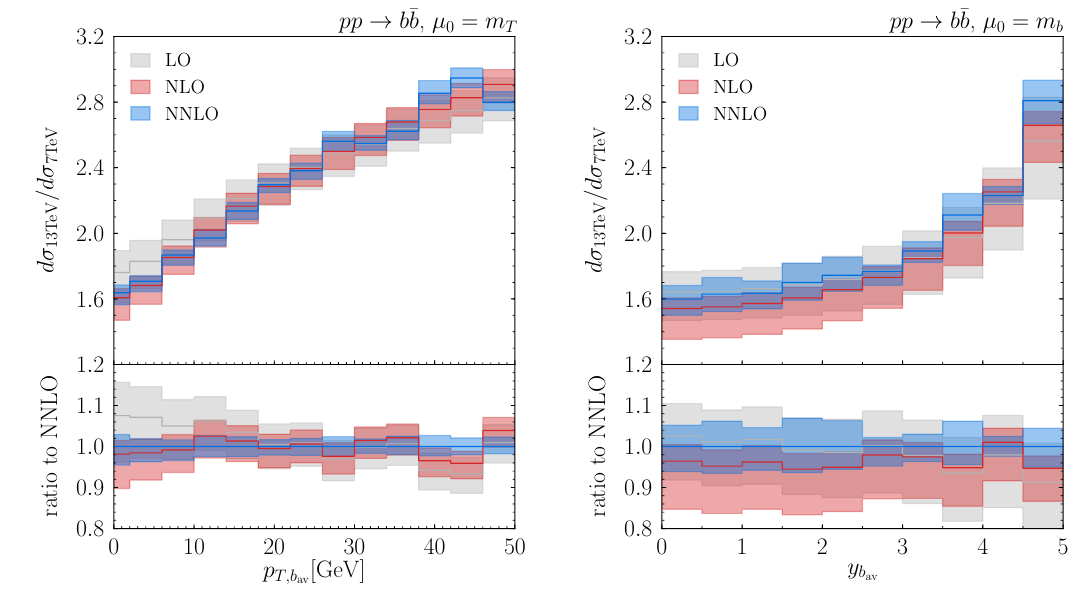
Figure 9 . Ratios of 13 TeV to 7 TeV predictions for the transverse momentum (left) and rapidity (right) distributions at the LHC. The lower panels show the result normalised to the NNLO pre-